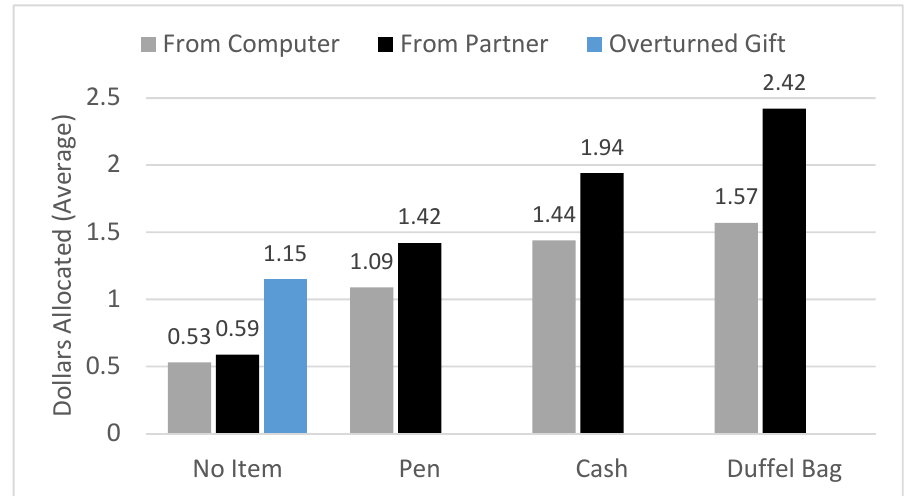
Figure 7. Average allocations by item and treatment. There are unbalanced numbers of observations from each dictator within each group; some dictators may factor more heavily into one average than another (for this reason, no standard error bars are shown, and the figure should be interpreted as only providing a general sense of dictator